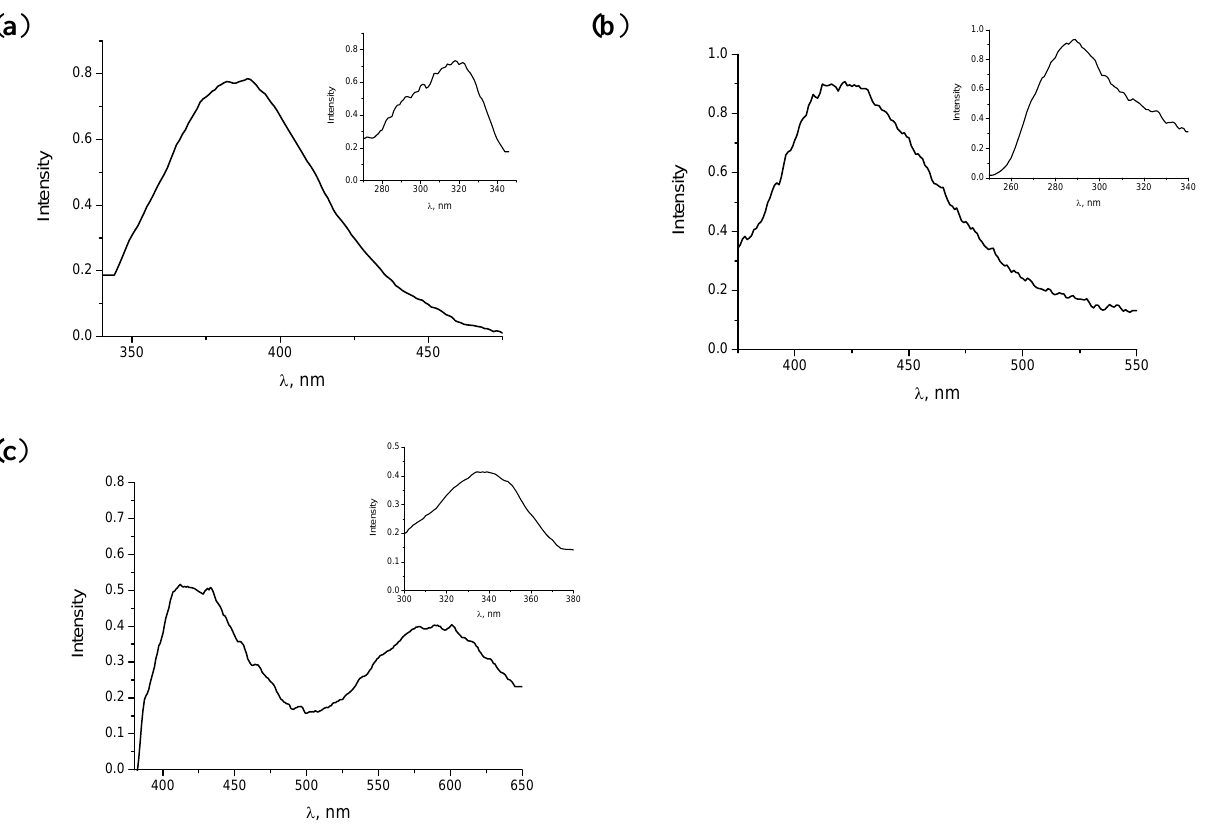
Figure 5. Fluorescence emission spectra of 1 in hexane at λ = 280 nm (b) and 340 nm (c). Inset: corresponding excitation λ exc